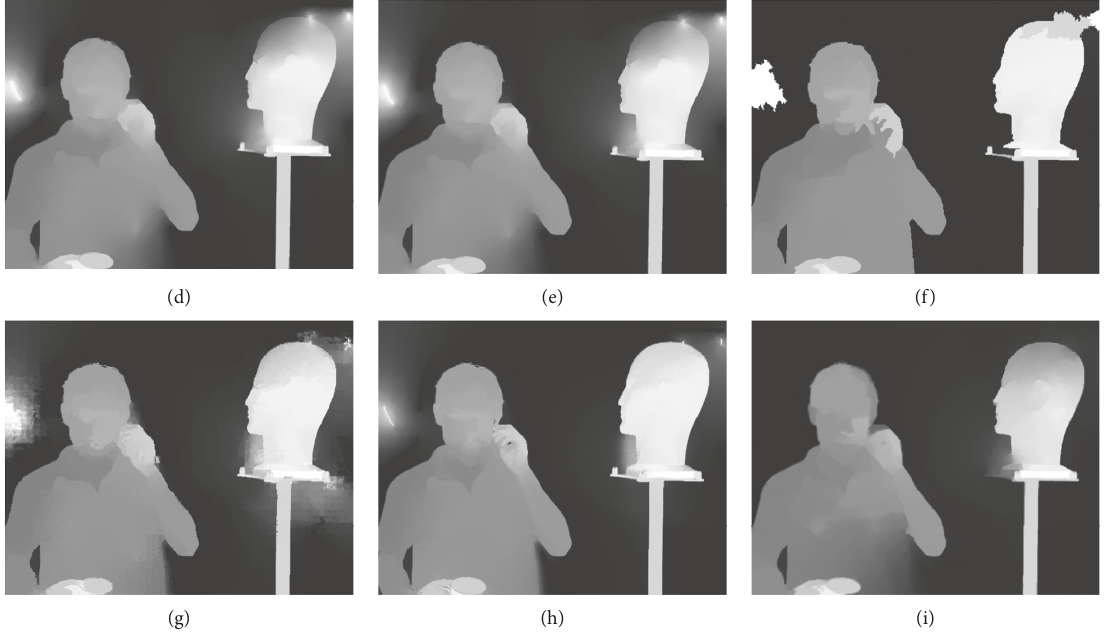
Figure 10: Results for RGBZ_05 in the presence of inaccurate scribbles. (a) Input image. (b) User scribbles. (c) Groundtruth. (d) Depth of RW [4]. (e) Depth of OPT [6]. (f) Depth of HGR [10]. (g) Depth of SOPT [13]. (h) Depth of NRW [14]. (i) Depth of